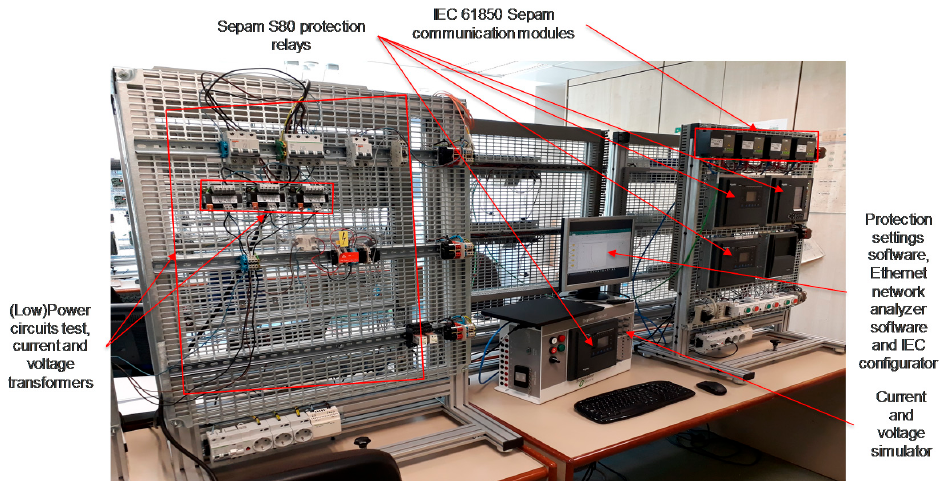
Figure 14. Laboratory mock-up.